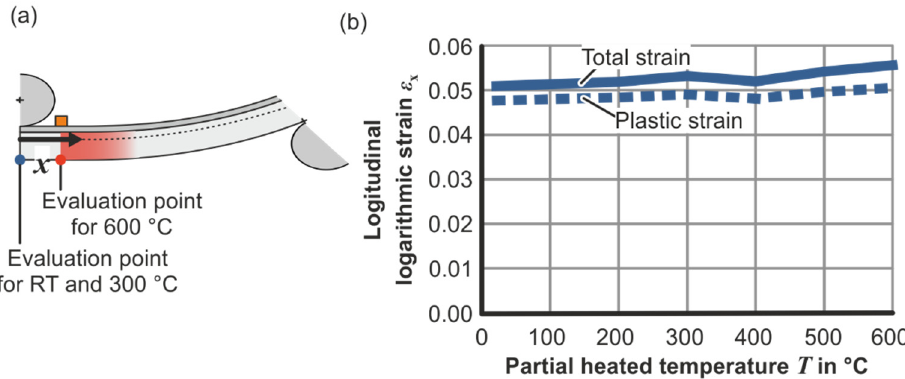
Figure A2. Difference between plastic strain and total strain. ( a ) evaluated position, ( b ) total strain and plastic strain evaluated through FE simulation for different partial heating temperatures.